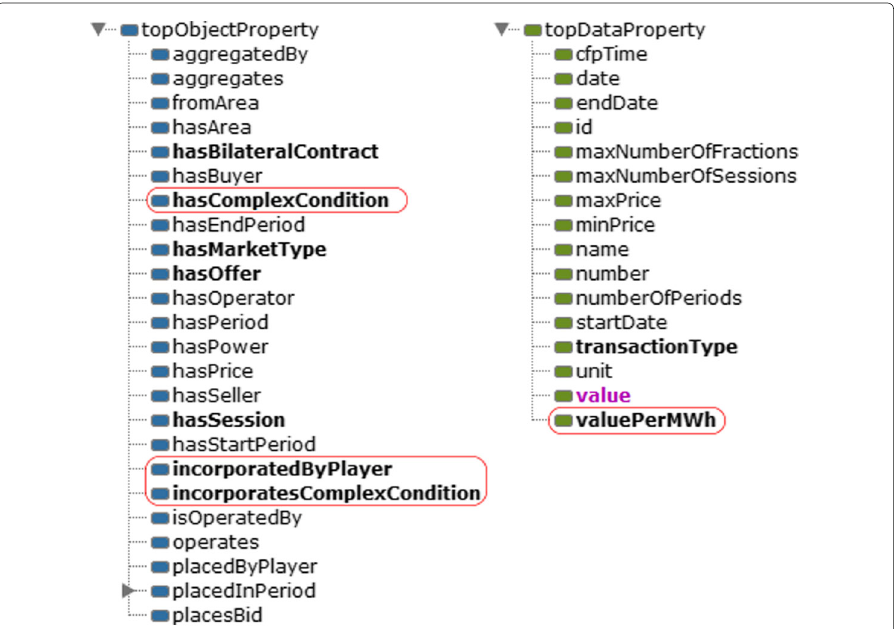
Fig. 2 MIBELOntology object and data